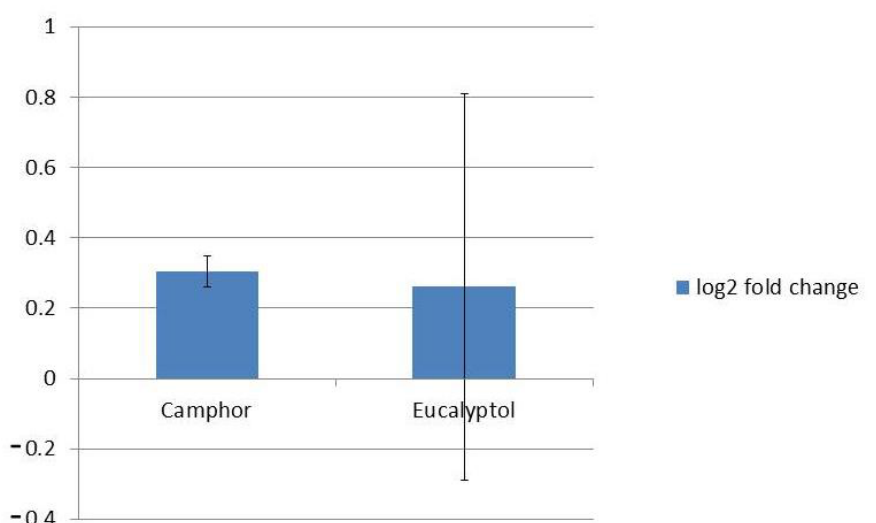
Figure 7. Expression levels of ERG11 after treatment with MIC of camphor and eucalyptol. Values are expressed as the log2 FC of RQ values and presented as an average of two biological replicates.